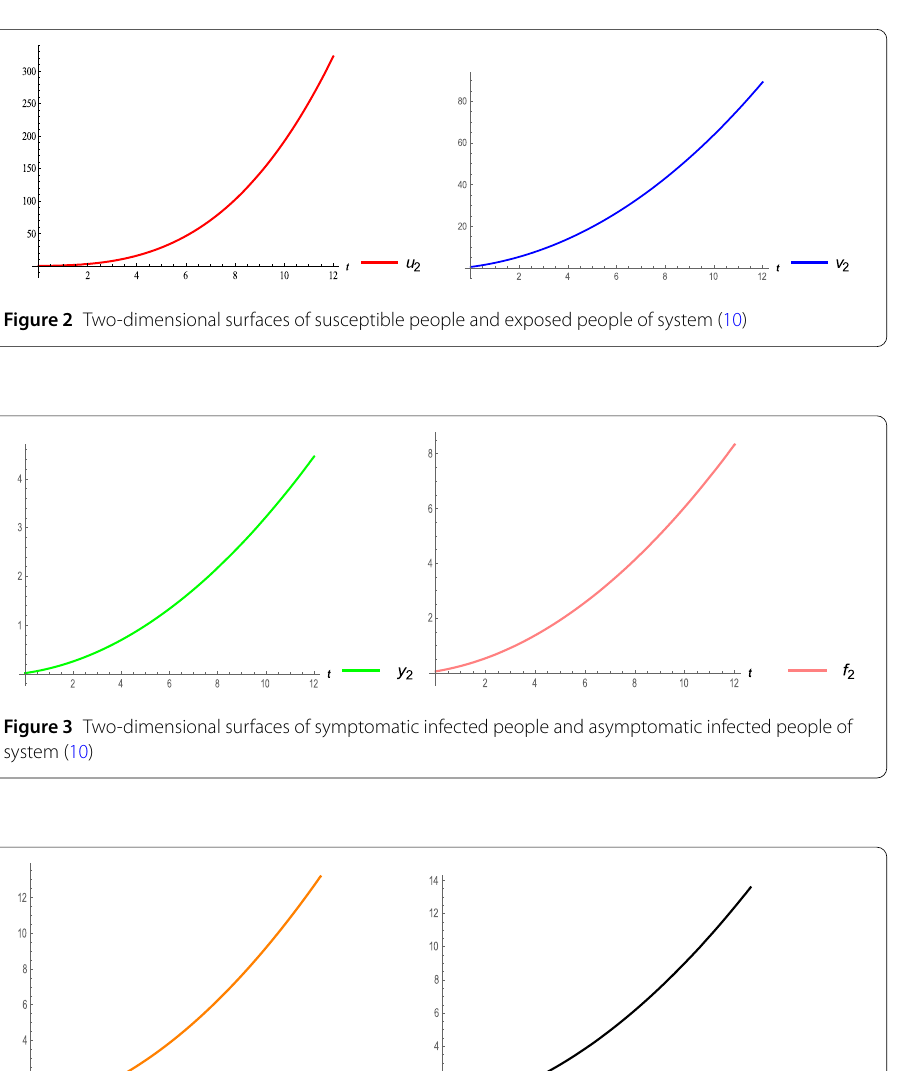
ably chosen values of the parameters, reported by WHO, we have plotted the numerical results. According to Figs. 1, 2, 3, 4, we observed that VIM produces similar distributions for susceptible people, which increase exponentially, when we compare the simulated data with Fig. 2 in [17]. Moreover, we can say that each class of system (1) has also simulated estimated behaviors from them. Furthermore, the spread of the 2019-nCoV with suscep- tible people u 2 is faster than the others, such as v 2 , y 2 , f 2 , r 2 , w 2 . Finally, from the second and more people from all over the world. As a future direction of this concept, application of powerful projected tools may be studied. These produce more comprehensive results on the mathematical system of